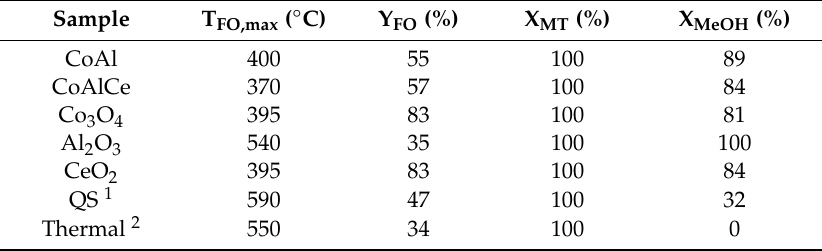
Figure 7. Experiments with the mixture of methanethiol and methanol: reactants and products’ concentrations over mixed oxides ( a ) and single oxides ( b ). Table 4. Comparison of samples in the reaction of the methanethiol and methanol mixture: formaldehyde yield; methanethiol and methanol conversions at maximum formaldehyde production